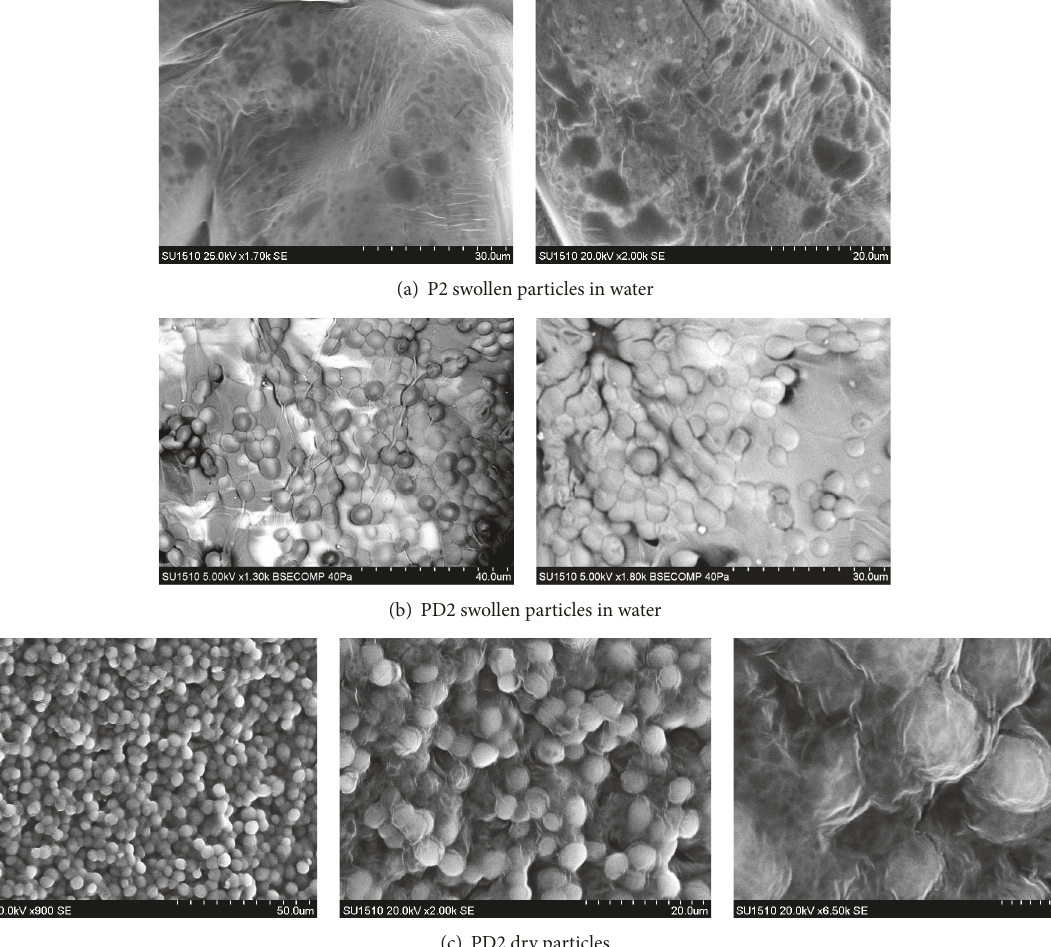
Figure 5: SEM images for P2 and PD2 swollen particles in water or in dry